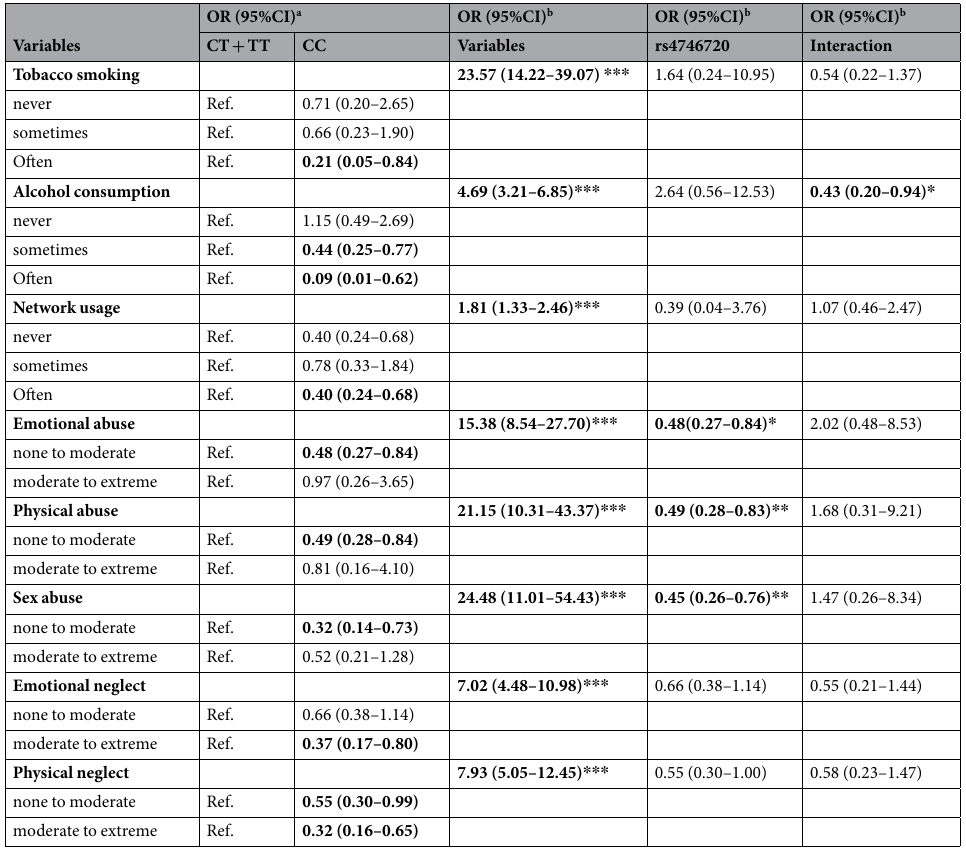
Table 5. Pairwise interactions between genetic variants of rs4746720. a Data calculated by univariate logistic regression; b Data calculated by multivariate logistic regression (Y = a0 + a1 X1 + a2 X2 + a1a2 X1 * X2); Positive results are in bold. * P < 0.05 (two-tailed), ** P < 0.01 (two-tailed), *** P < 0.001